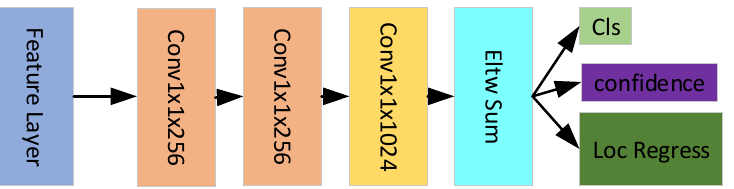
Figure 5. Prediction module. This module was proved to be an efficient prediction module and was used as the detection part in DSSD. The outputs of this module in DSSD are the probability of classes and location information, while the confidence information is added in the proposed framework.